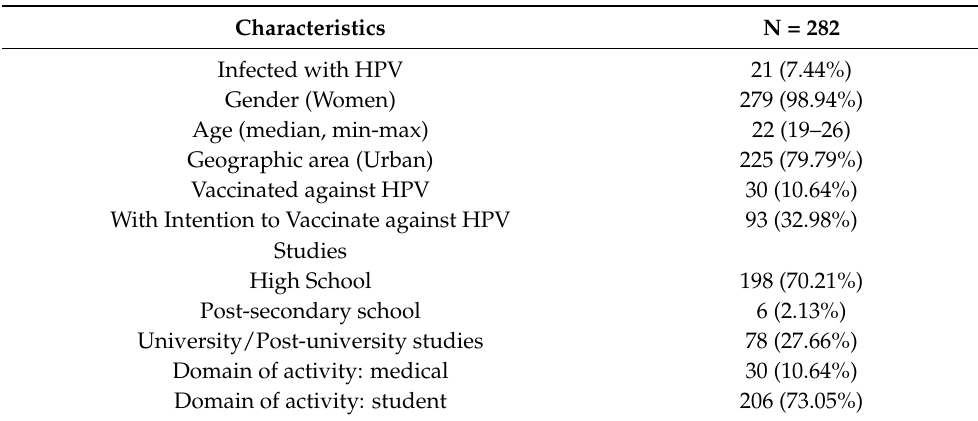
Table 5. Vaccination/infectious HPV status and socio-demographic and educational characteristics of respondents with ages less than 27